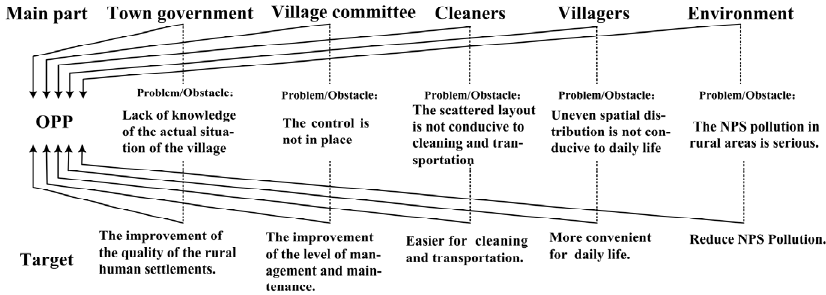
Figure 5. Actors and OPP in optimising the layout of garbage bins.